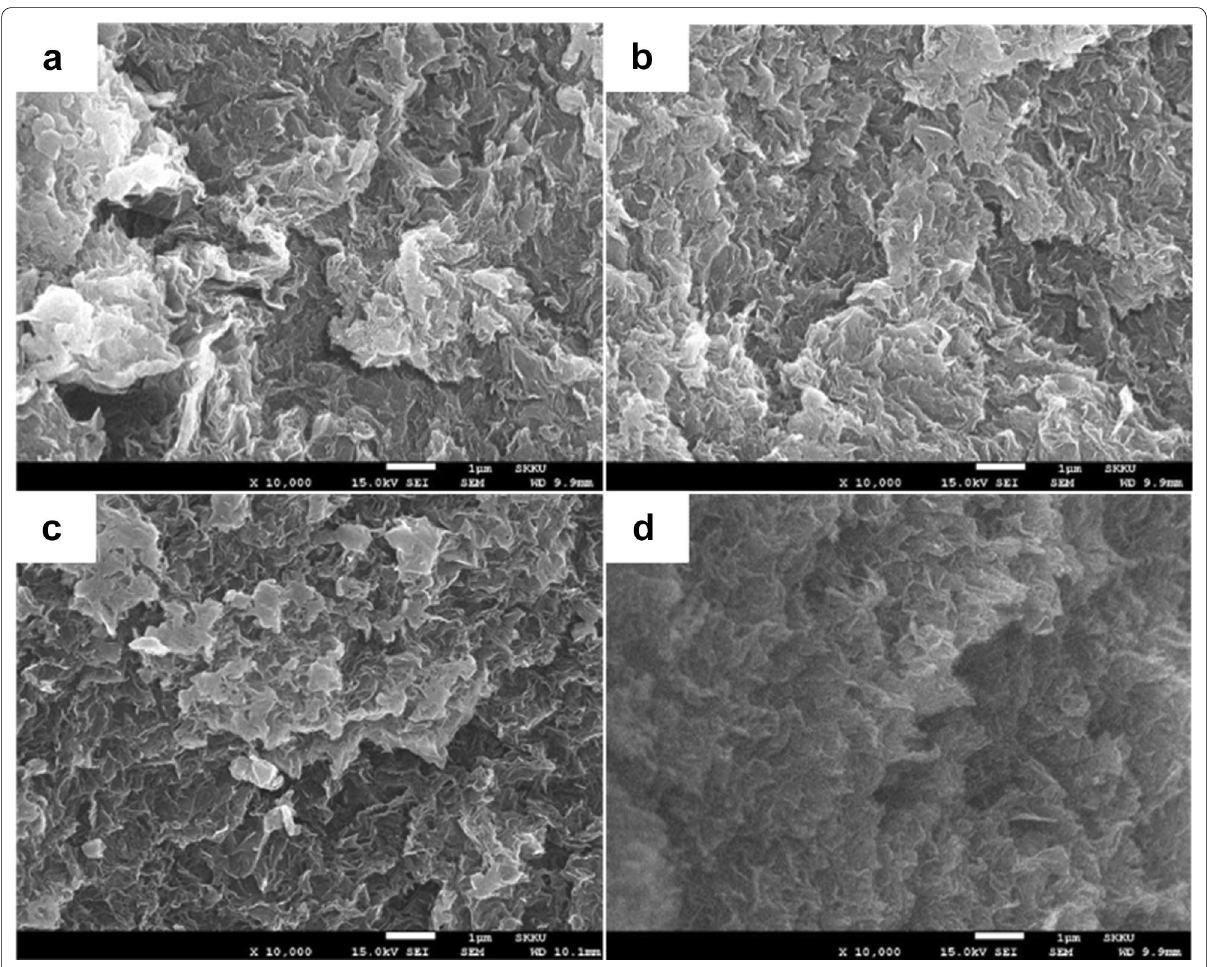
Fig. 4 SEM images of the freeze-dried GCCHCs: a GC_5; b GC_10; c GC_15, and d